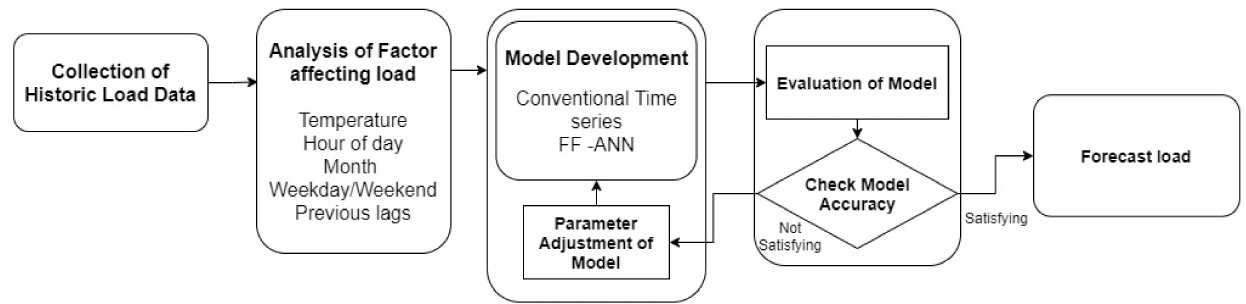
Figure 8. Forecasting